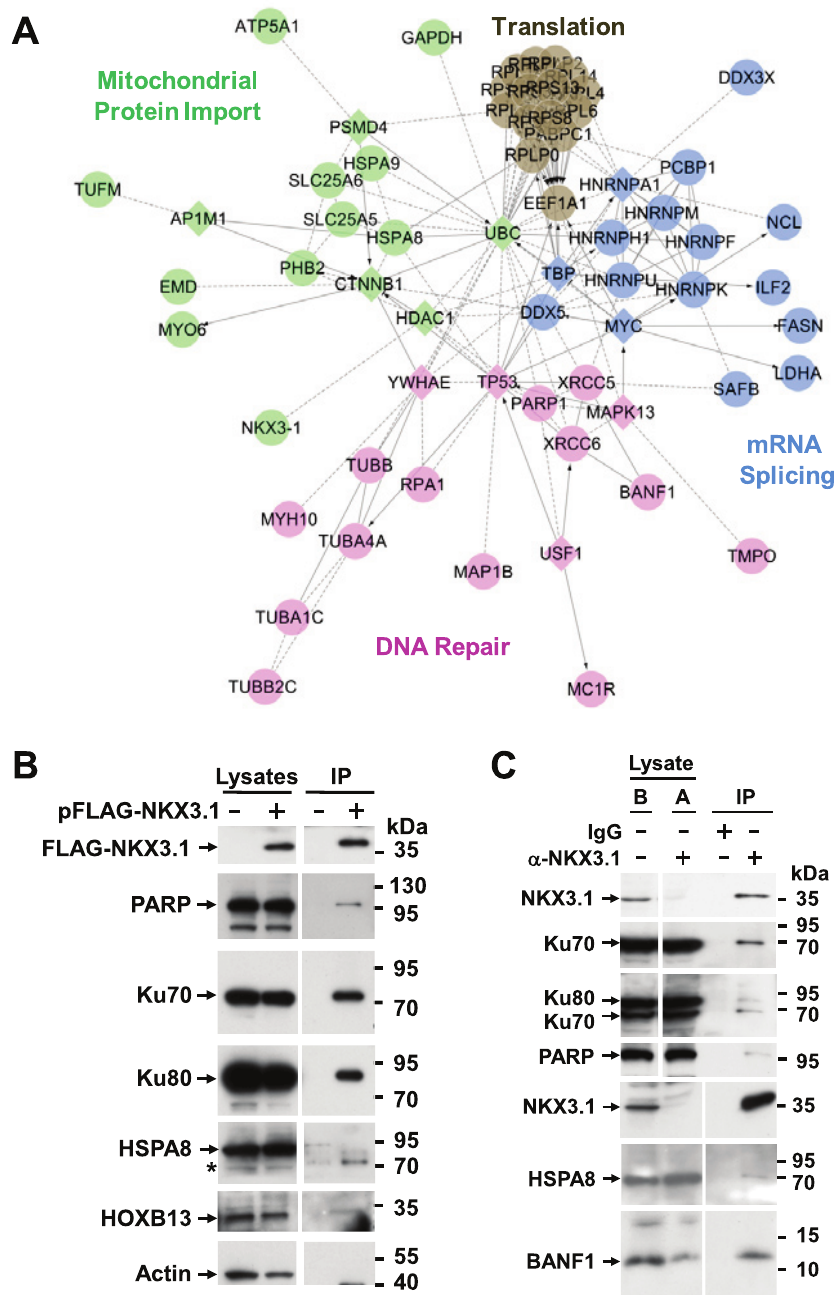
Figure 2. NKX3.1 interacts with DNA repair proteins. ( A ) The list of NKX3.1 interacting proteins was loaded into Cytoscape and used to build Reactome Functional Interaction networks. The networks were clustered into modules (indicated by colors), and pathways enriched in the modules (FDR ≤ 0.01) were identified. Diamonds represent network components that were not identified as NKX3.1 interacting proteins. ( B ) LNCaP cells were transfected with FLAG-NKX3.1 (+) or empty vector (-) followed by absorption of cell lysate to FLAG M2 resin to purify FLAG-NKX3.1. Co-purifying DNA repair proteins were detected by immunoblotting. The bottom four panels are from the same affinity purification resolved on a separate gel. The asterisk denotes an unspecific cross-reactivity of the HSPA8 antibody. Cropped blot images are shown; see Figure S7 for full images. ( C ) A nuclear protein fraction was prepared from LNCaP cells and employed for immunoprecipitation with NKX3.1 antibodies or an IgG control as indicated. The same samples before (“B”) and after (“A”) immunoprecipitation are shown to document the specific depletion of endogenous NKX3.1. The bottom three panels are from the same immunoprecipitate resolved on a separate gel. Cropped blot images are shown; see Supplement Figure S7 for full